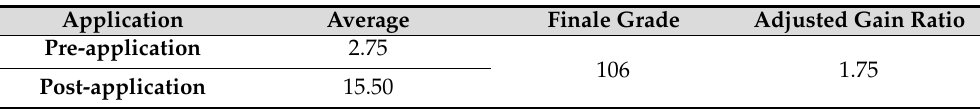
Table 8. Adjusted gain